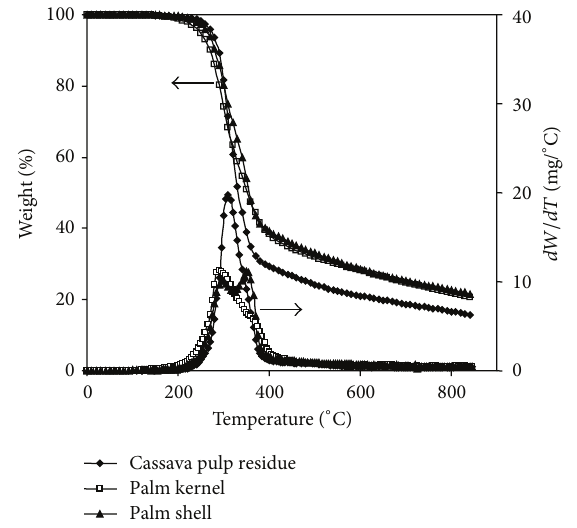
Figure 3: TG and DTG data of palm shell, palm kernel, and cassava pulp